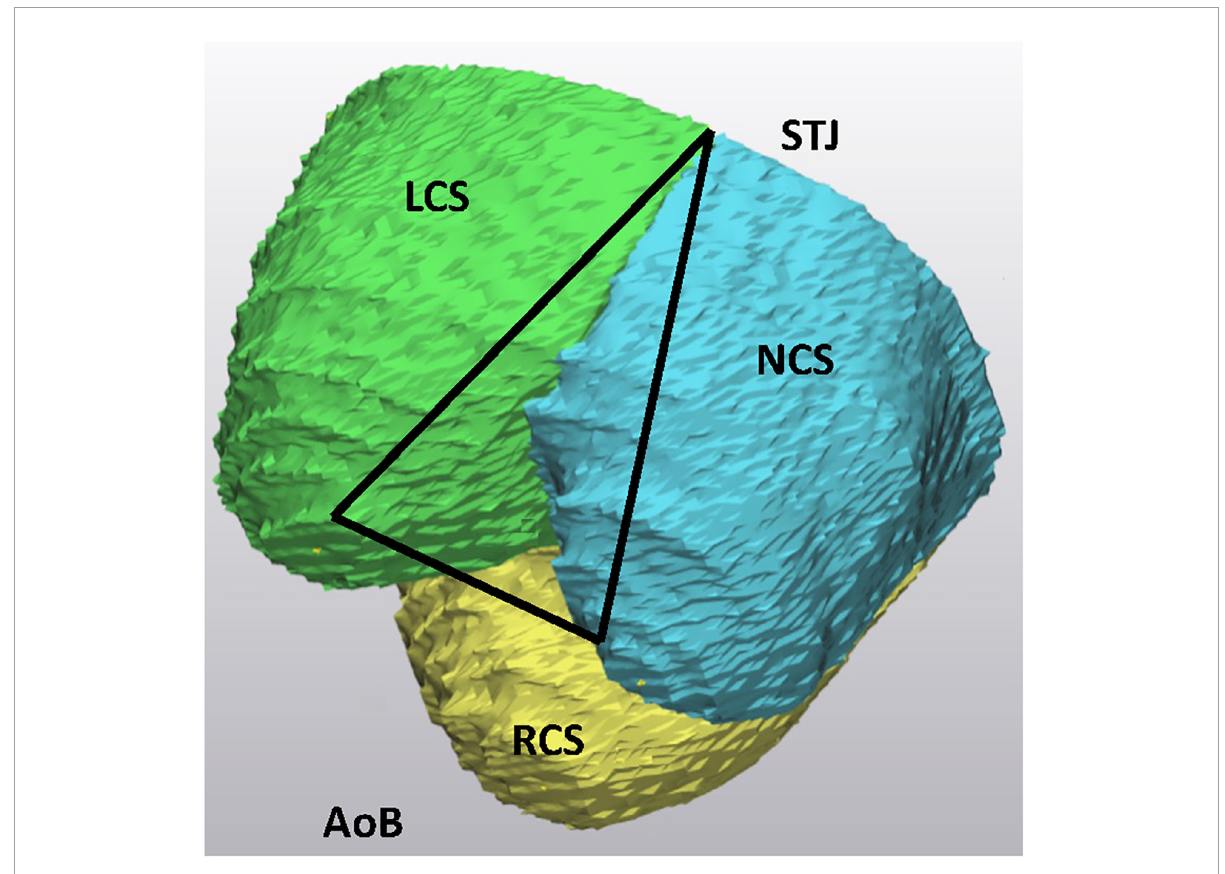
FIGURE4 The intervalvular triangle, as seen on 3D models of the aortic root. The peak of the triangle corresponds to the commissure at the level of the STJ. AoB, aortic root base; STJ, sinotubular junction; LCS, left coronary sinus; RCS, right coronary sinus; NCS, non-coronary